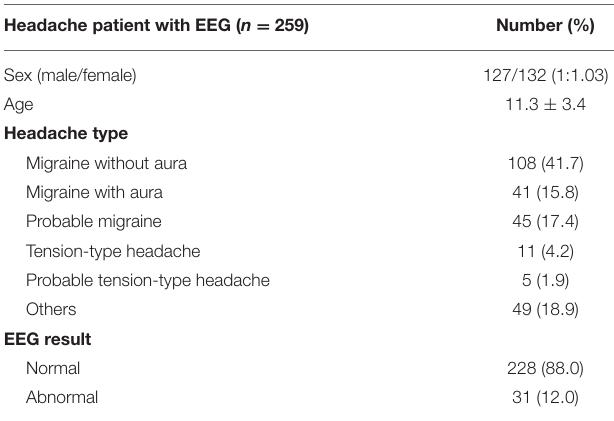
TABLE 1 | Clinical characteristics of the headache patients with electroencephalograms